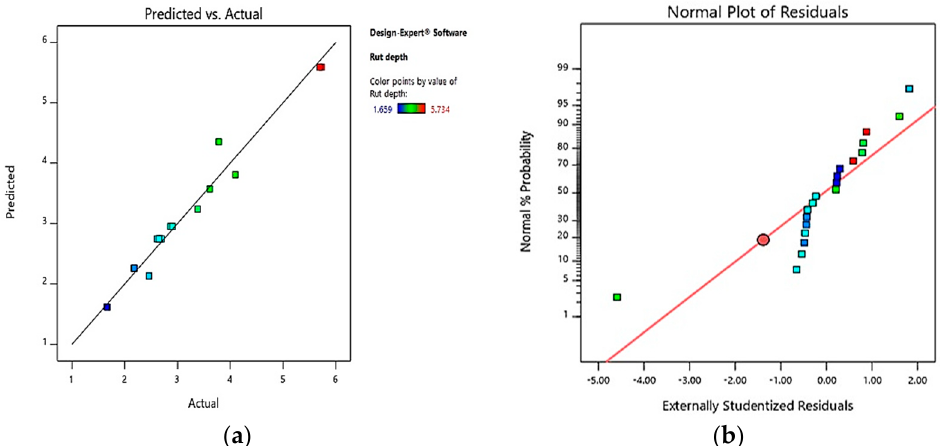
Figure 10. Rutting response plots for ( a ) predicted against actual, ( b ) normal plots of